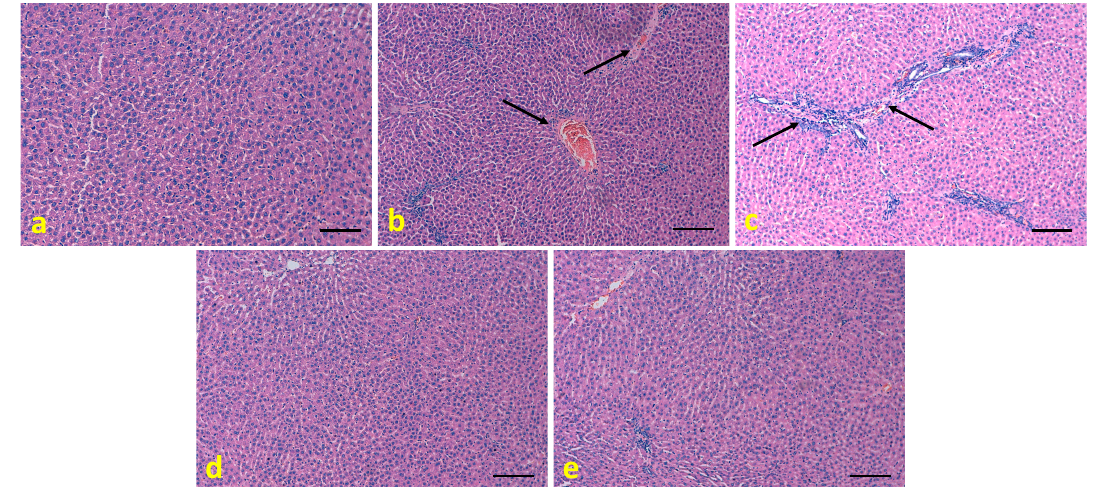
Figure 10. The role of TQ in the maintenance of liver architecture. ( a ) The normal morphology of hepatocytes was seen in normal control group. ( b , c ) The diabetic liver sections from STZ-induced rat groups showed congestion, hemorrhages, edema, and enhanced inflammatory cells. ( d ) The histopathological examination of liver sections from treatment group (STZ + TQ) showed preservation of hepatocyte structure, mild degeneration, hemorrhages, infiltration of lymphocytes. ( e ) Normal architecture of hepatocyte of PC group (Scale bar = 100 μ m).